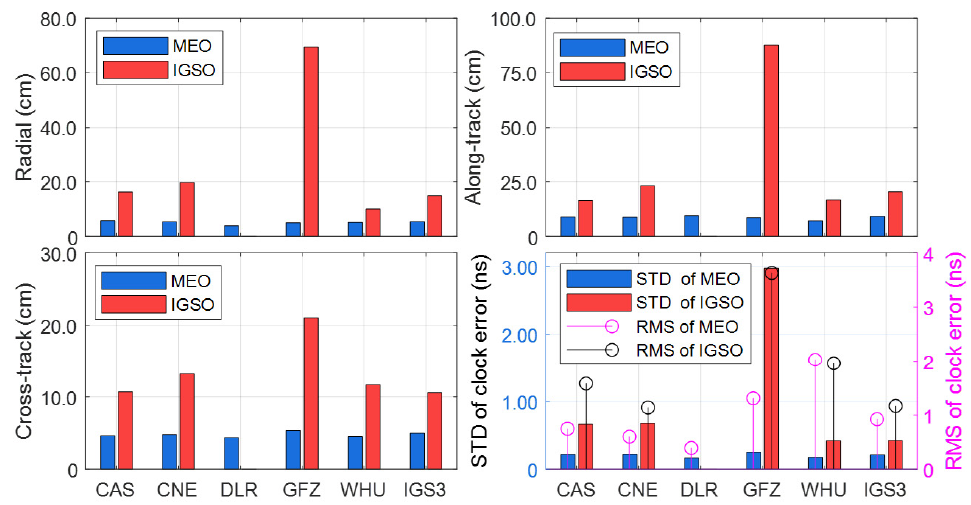
Figure 6. The accuracy of BDS SSR products. The STD (Left y axis and blue for MEO, red for IGSO) and RMS (Right y axis and magenta for MEO, black for IGSO) of clock errors is presented in the lower-right subplot.